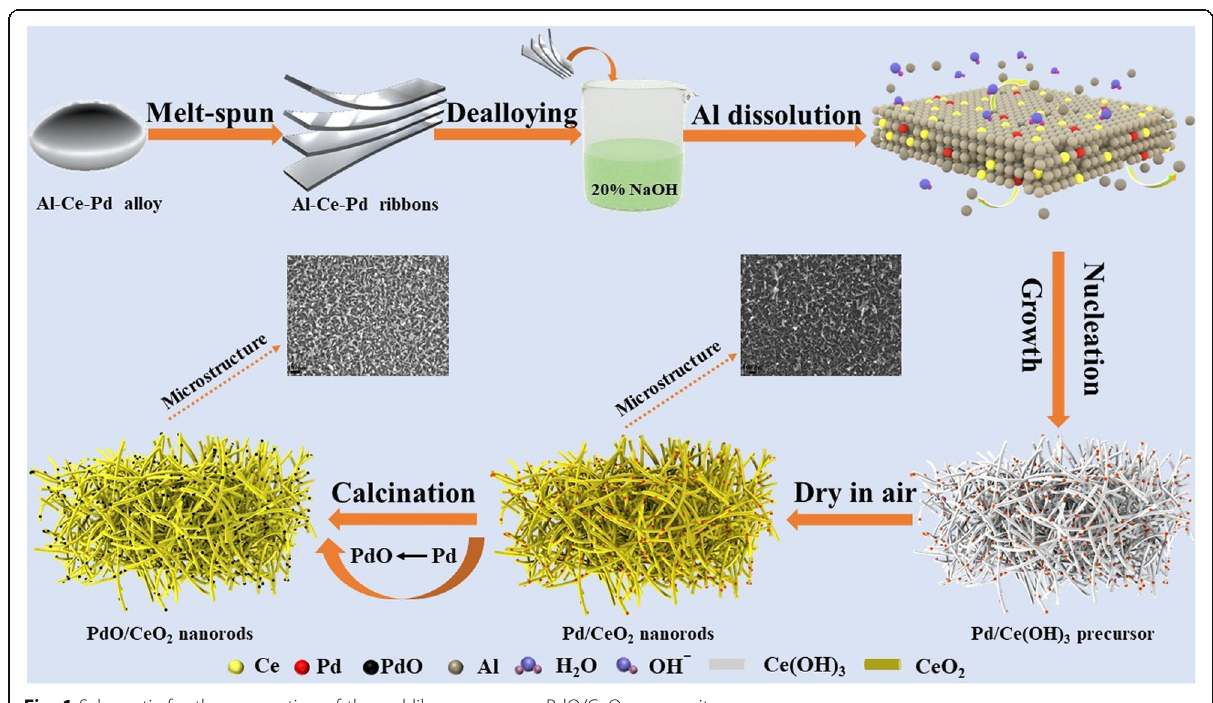
Fig. 1 Schematic for the preparation of the rod-like nanoporous PdO/CeO 2 composite